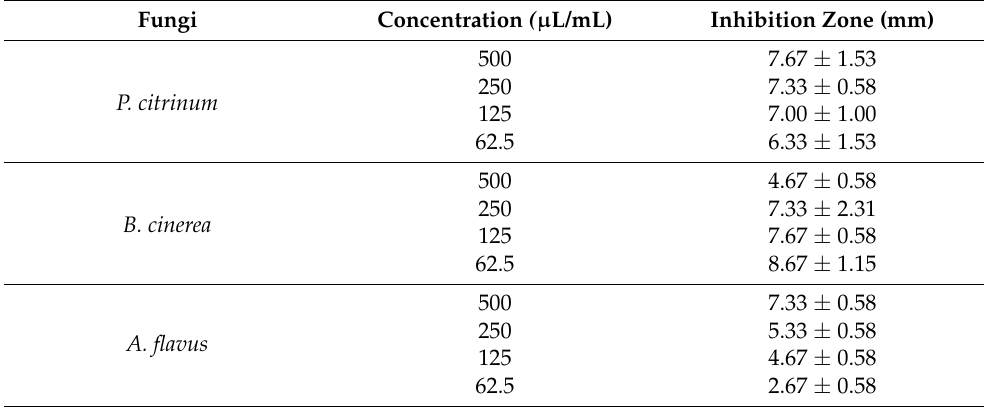
Table 5. Minimum inhibitory concentrations of CSEO against microscopic